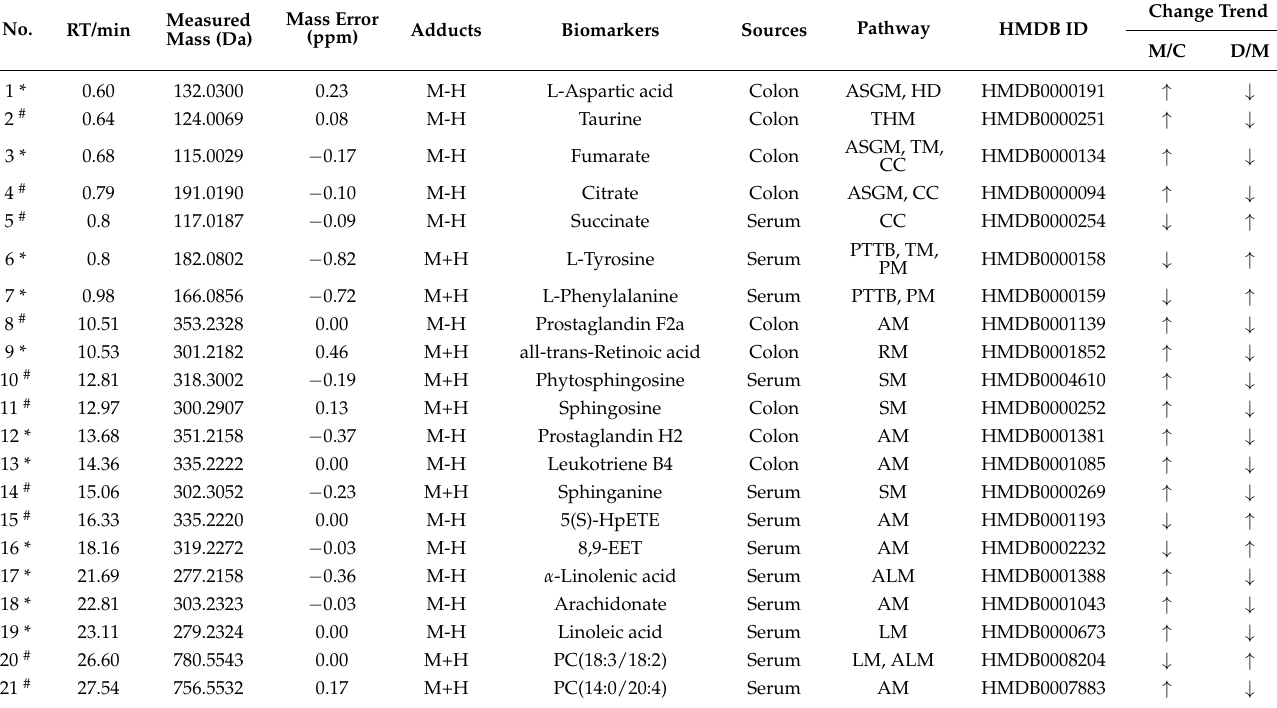
As potential biomarkers, 21 endogenous metabolites were identified (Table 3). After that, these potential biomarkers from different groups were visualized and mapped on the heat map (Figure 9C). From blue to red, the colors indicated increasing abundance of the metabolites. Table 3. The information of identified metabolites in serum and